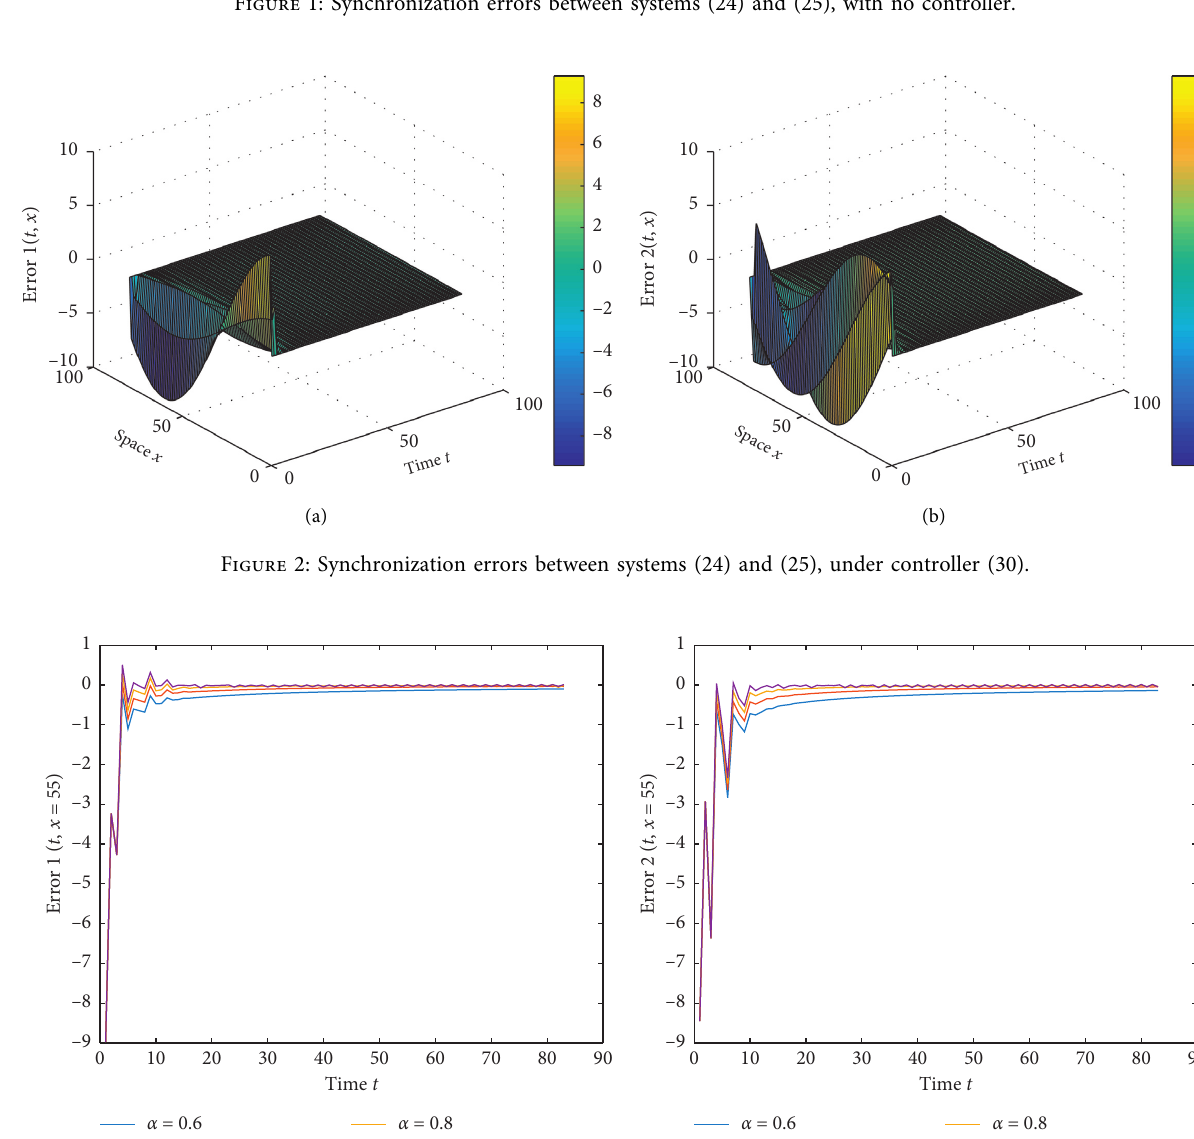
Figure 1: Synchronization errors between systems (24) and (25), with no controller.